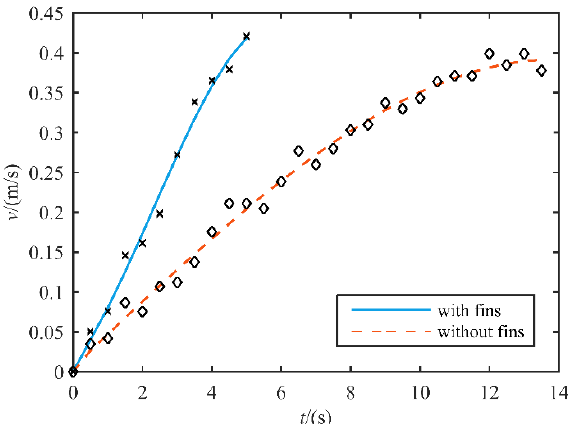
Figure 12. Velocities of the spherical robot with fins and without fins.